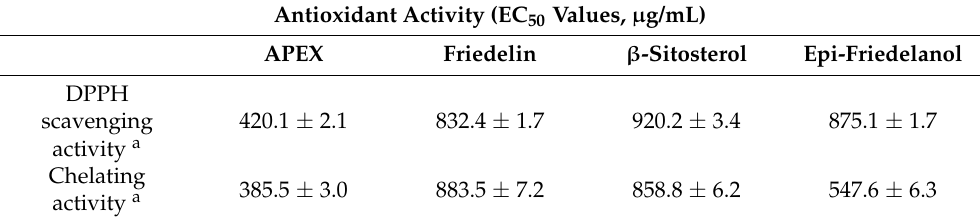
Figure 3. In vitro antioxidant capacity. Scavenging effect as assayed with the DPPH test ( A ); chelating ability on ferrous ions ( B ). Each value is the mean ± SEM of three independent measurements. The EC 50 values for APEX, FR, ST and EFR calculated from the results of the DPPH and Fe 2+ -chelation assays are reported in Table 3. Table 3. EC 50 DPPH and Fe 2+ -chelating